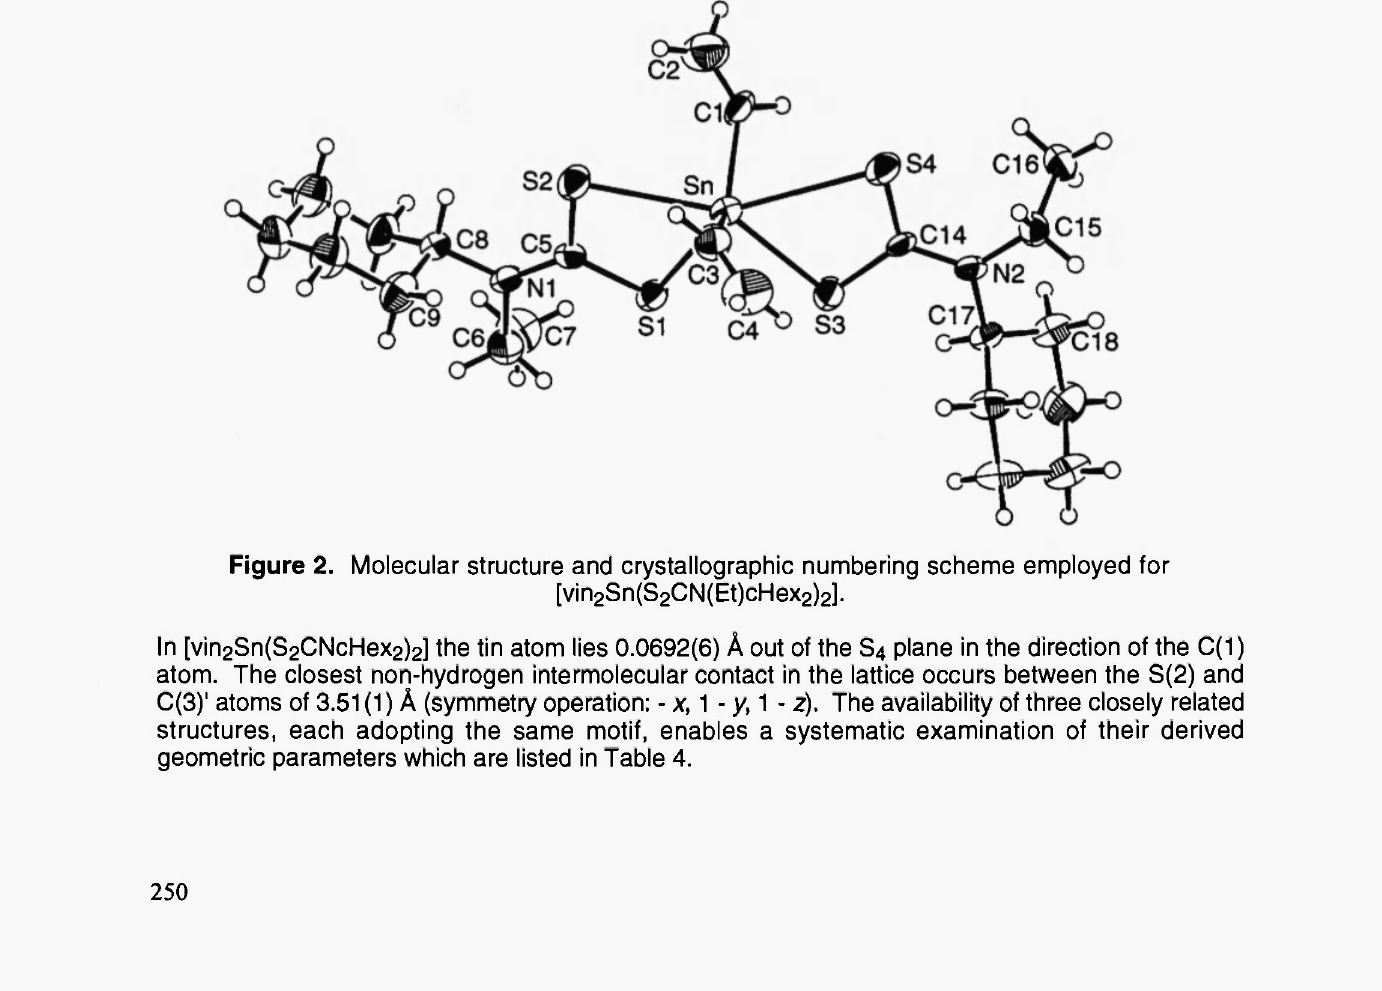
Figure 1. Molecular structure and crystallographic numbering scheme employed for